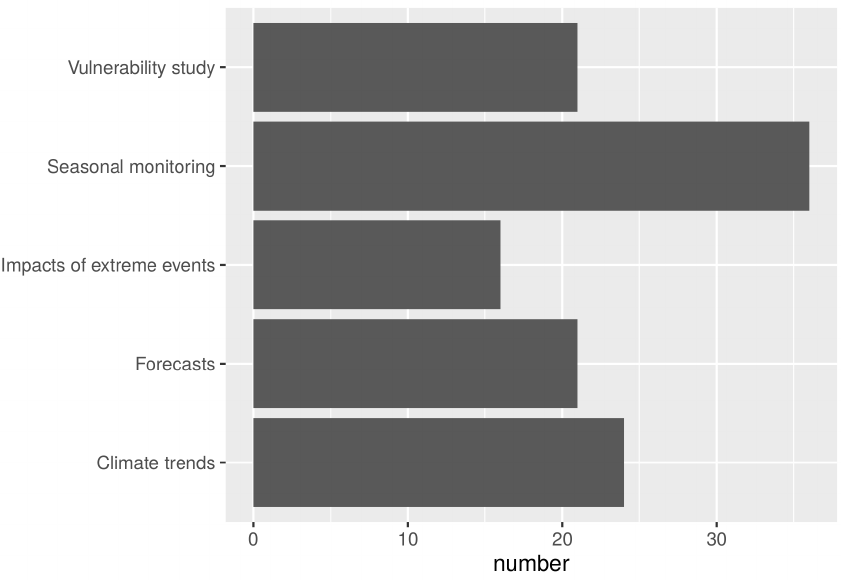
Figure 6. Responses of the question, on ’What do you use the eStation for?’ Multiple answers